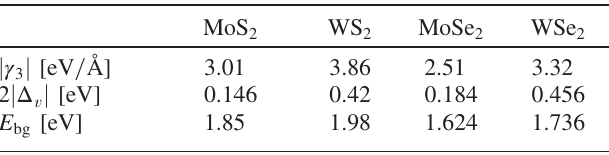
TABLE VII. Parameters appearing in the expressions for g and g for different so